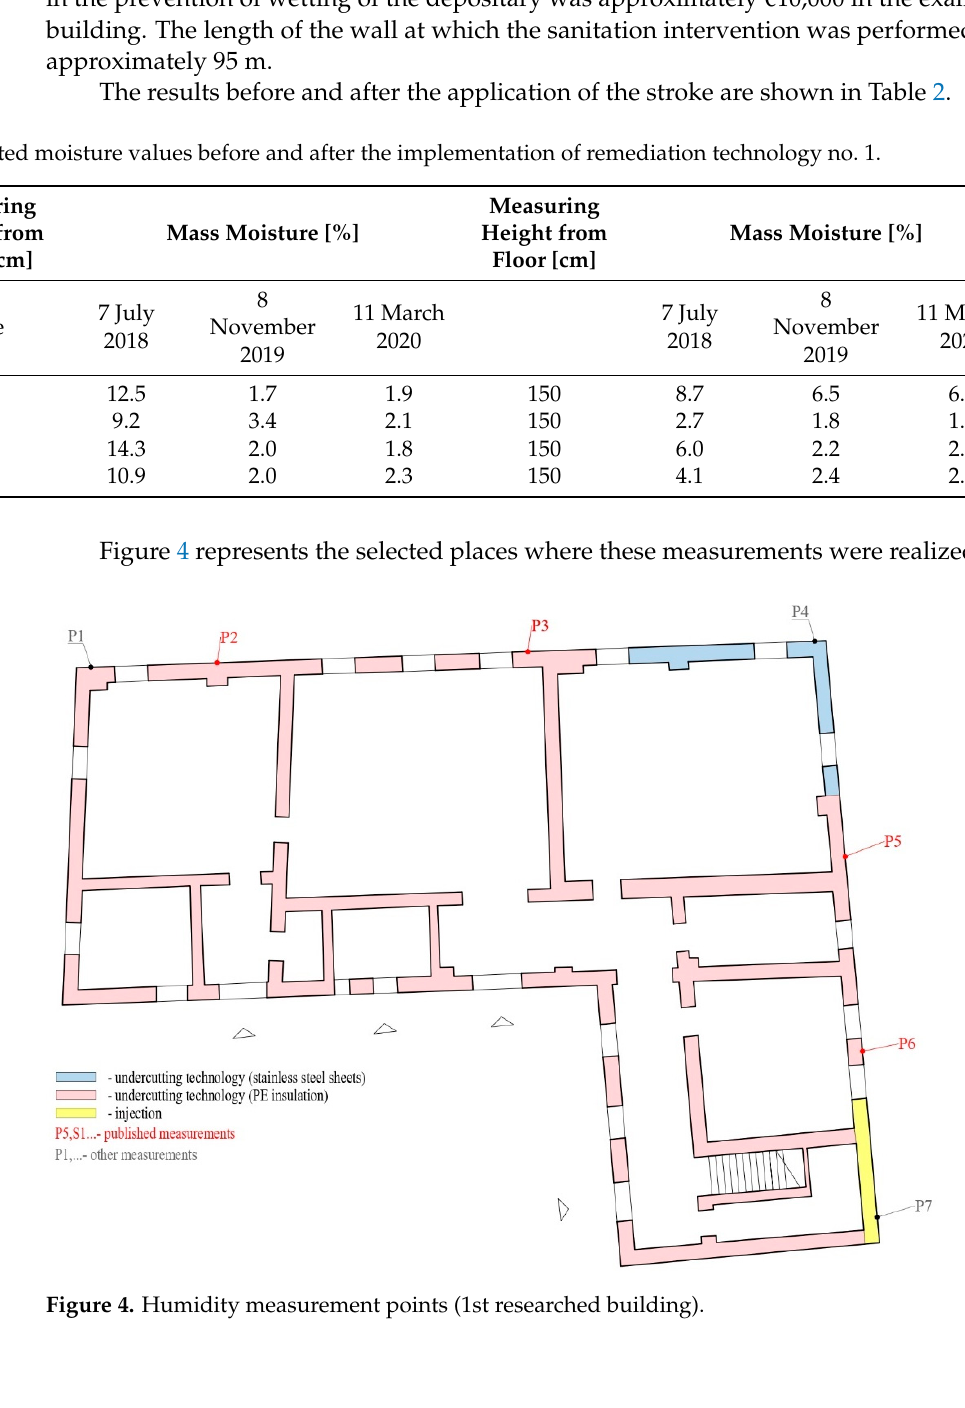
( b ) Figure 5. View on the state of building ( a ) before and ( b ) after recovery.